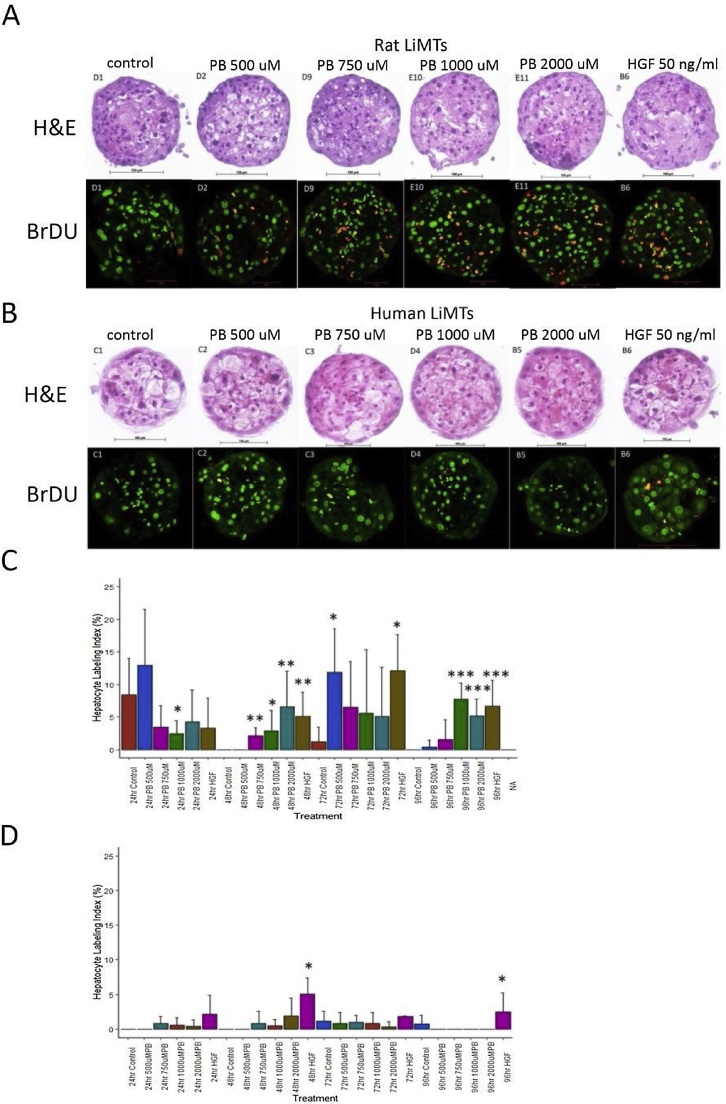
Effect of PB treatments on hepatocyte proliferation (LI%) in rat and human LiMTs.(A) rat and (B) human LiMTs showing representative images of H&E stained (top panels) or anti-BrDU immunofluorescence (IF) stained (bottom panels) LiMTs from parallel microTMA sections. (C) and (D) are histograms of hepatocyte proliferation (LI%) data derived from image analysis of BrDU IF stained rat and human LiMT sections, respectively. Results are mean ± SD, n = 4-8. *, **, *** significantly different from control by Student's t test, p < 0.05, p < 0.001, p < 0.0001, respectively. The data ware representative of at least two separate experiments performed on different batches of spheroids.